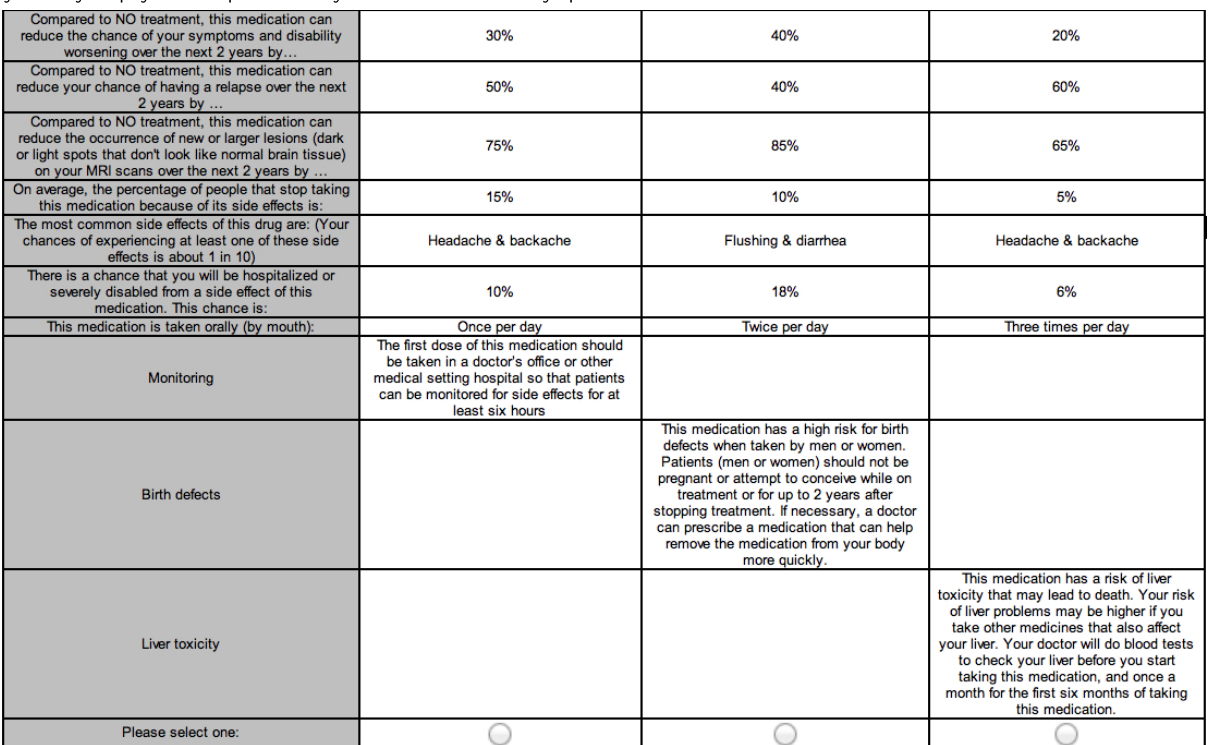
Figure 1. Example screenshot from Conjoint Analysis Exercise 1 (CA1) – Participants were asked “Of these three products, which would you be most likely to ask your physician to prescribe to you if these were the only options